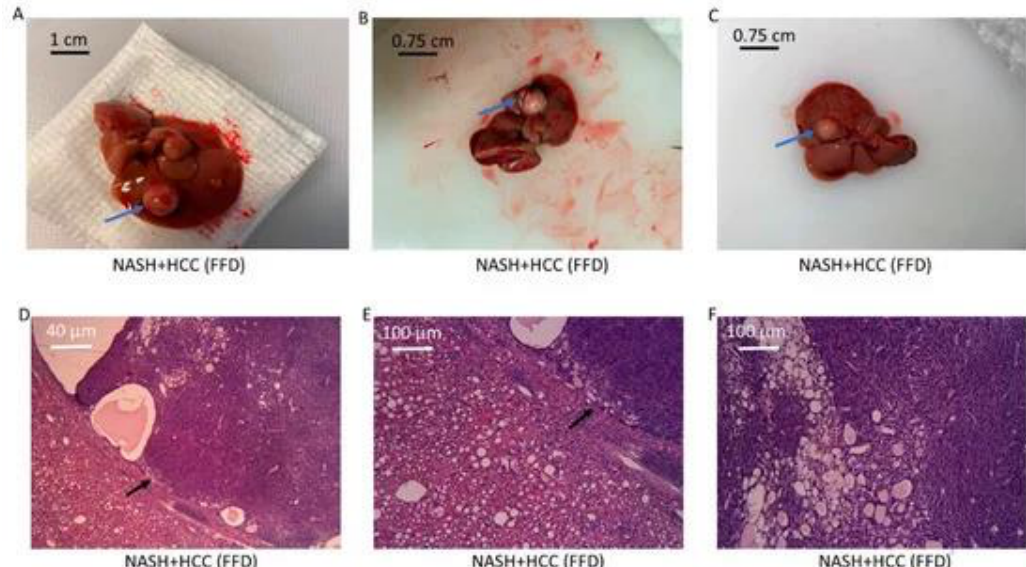
Figure 5. HCC. ( A – C ) Several animals within the FFD (17 months) cohort exhibited tumors (blue arrows) on the surface of the liver. ( D – F ) Representative H&E-stained section from an FFD (17 months) liver with ( F ) showing abnormal hepatocytes and clusters of nuclei. There is a distinct margin between the noncancerous and cancerous parenchyma (black ar- rows, ( D ) and ( E )).